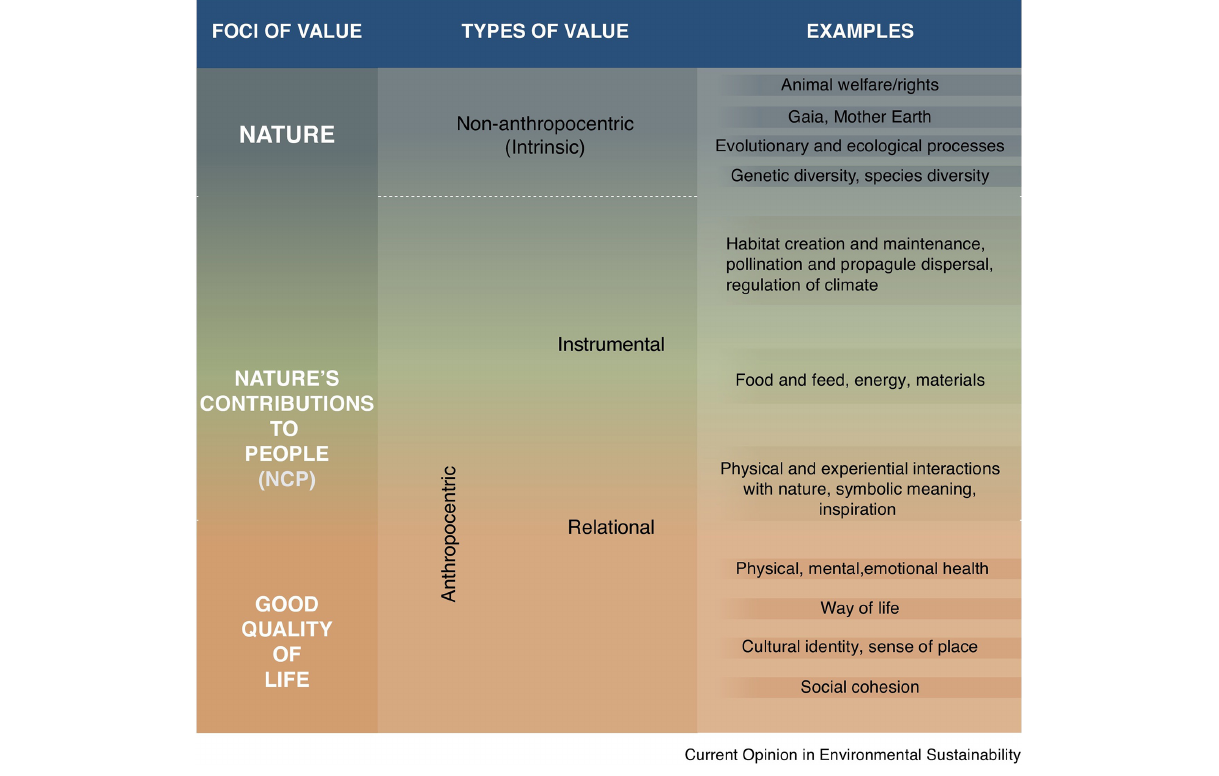
FIGURE 4 | Diverse values related to nature, nature’s contributions to people and a good quality of life. The grading in the colors indicates that both instrumental and relational values can be ascribed to the value of nature’s contributions to people, and to highlight that it is intertwined with nature and a good quality of life. Reproduced from Pascual et al. (2017); open access under the Creative Commons Attribution-Non-commercial-No Derivatives License - CC BY-NC-ND